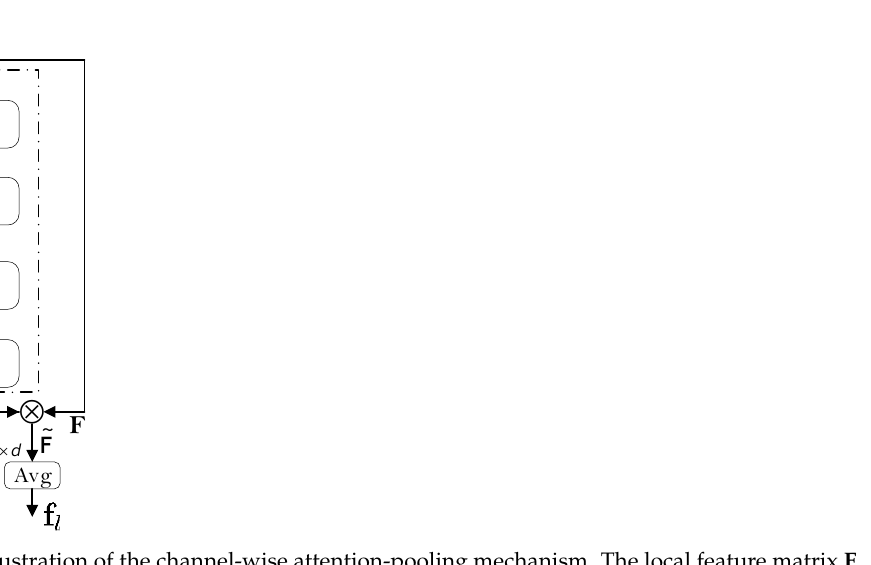
Figure 6. Illustration of the channel-wise attention-pooling mechanism. The local feature matrix F is reweighted along the patch dimension to give more importance to more informative local image patches. Shown is the architecture, implemented in the model we have